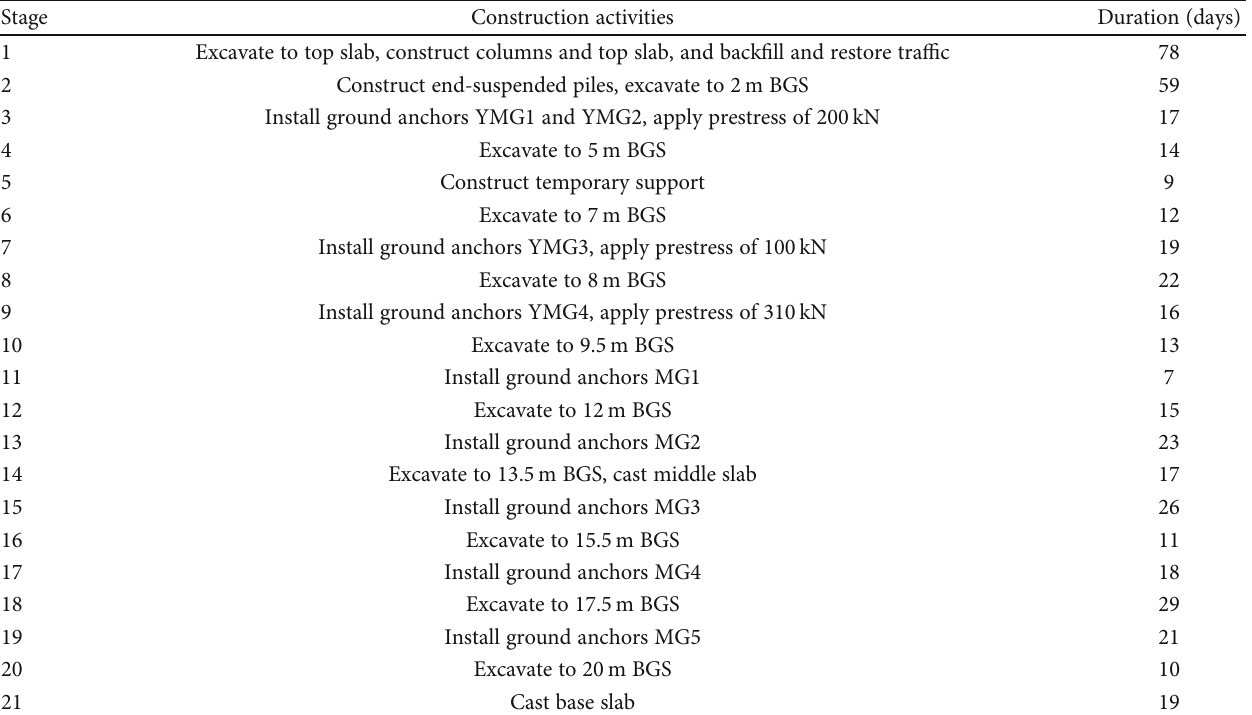
Table 1: Summary of the main construction activities.